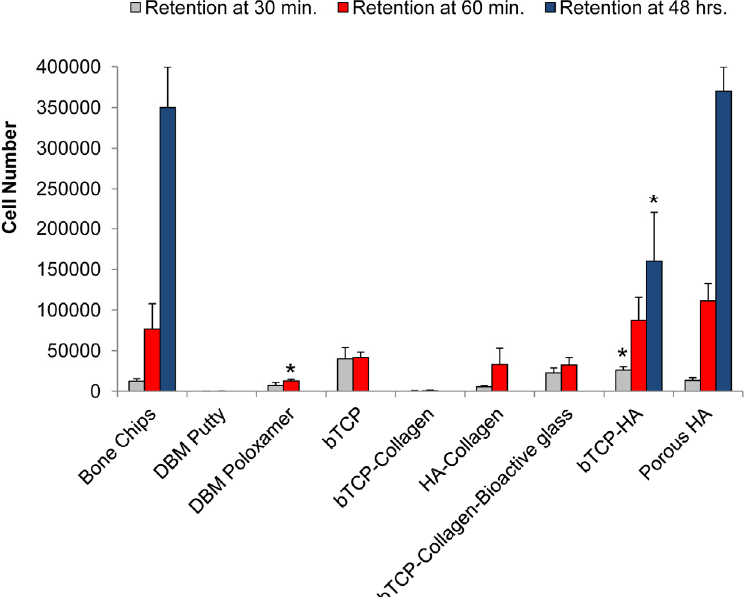
Figure 1. Bone marrow stromal cell retention on insolubilized substrates after 30 min, 60 min, and 48 h of incubation at 37 °C. Error bars represent standard error of the mean ( n = 4 per substrate). Asterisk denotes significant difference ( * p < 0.05) against the appropriate bone chip measurements by ANOVA and Dunnett post test.